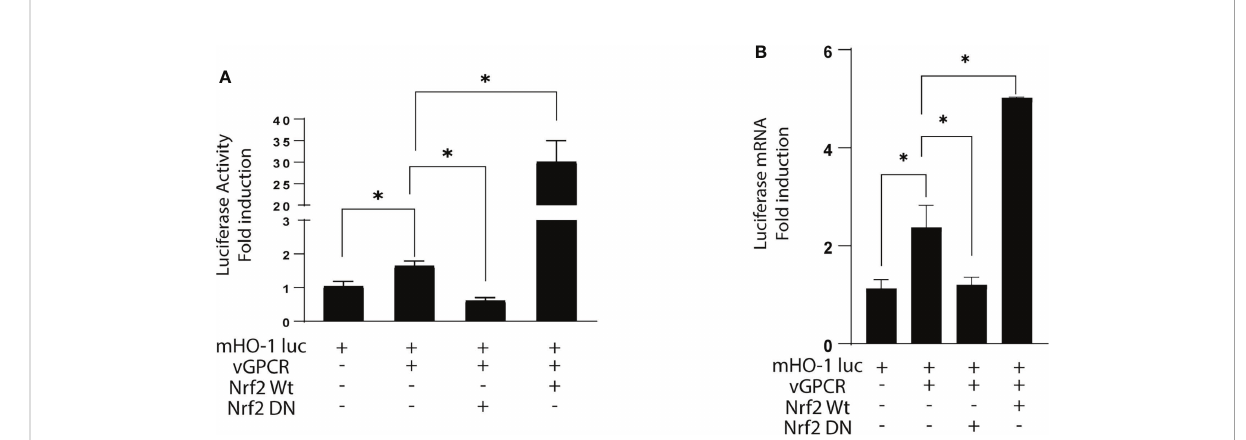
FIGURE 2 (A) Luciferase activity of the murine HO-1 promoter after transfection with vGPCR; co-transfection with Nrf2 WT and the dominant negative Nrf2 DN. The results are expressed as fold induction relative to control cells (transfected with the reporter and an empty vector). (B) Fold- changes of Luciferase mRNA expression were assessed by RT-qPCR in triplicate and are presented as means ± SD. (*P <0.05). p-value < 0.05